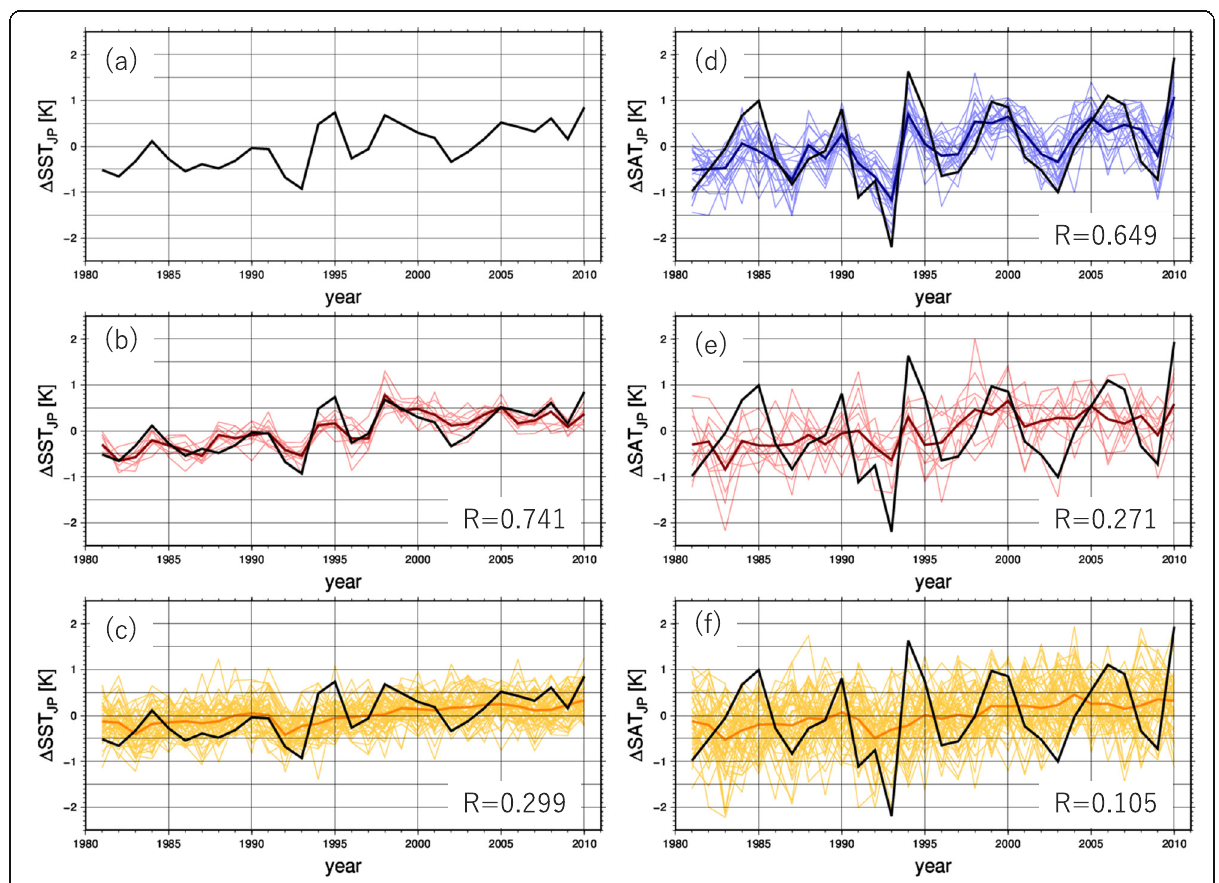
Fig. 2 Time series of SST anomalies around the Japanese islands (SST JP , left) and SAT anomalies over land of the Japanese islands (SAT JP , right) for August 1981 to 2010, obtained from a , d AMIP, b , e CAssm, and c , f CHist experiments. Black lines of SST JP and SAT JP anomalies mean those in COBE-SST2 and JRA-55, respectively. Colored thin and thick lines show the anomalies of each ensemble member and the ensemble average,